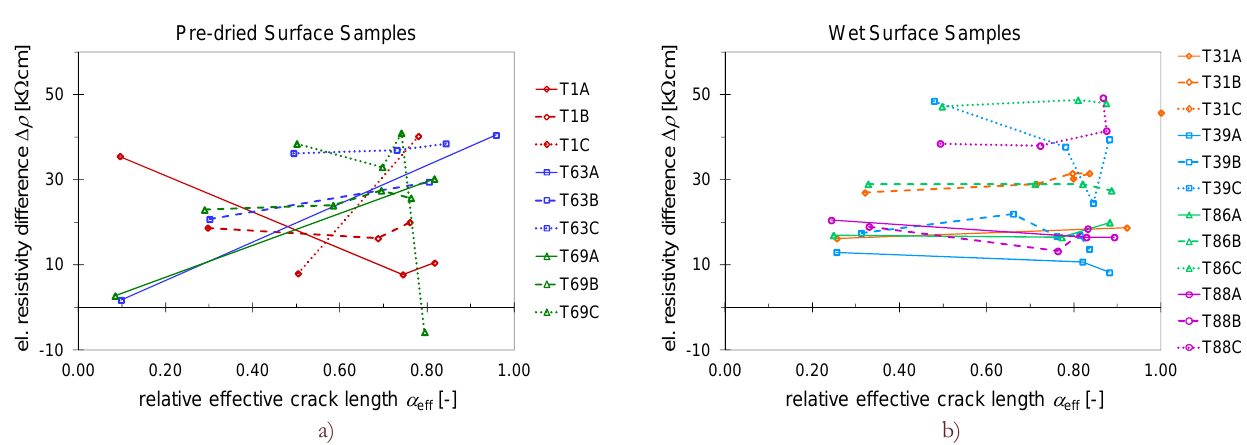
Figure 5: Relationship between the concrete electrical resistivity difference,  , and the relative effective crack length,  eff , for the pre-dried (a) and the wet surface (b) samples evaluated at the notch (n) level.